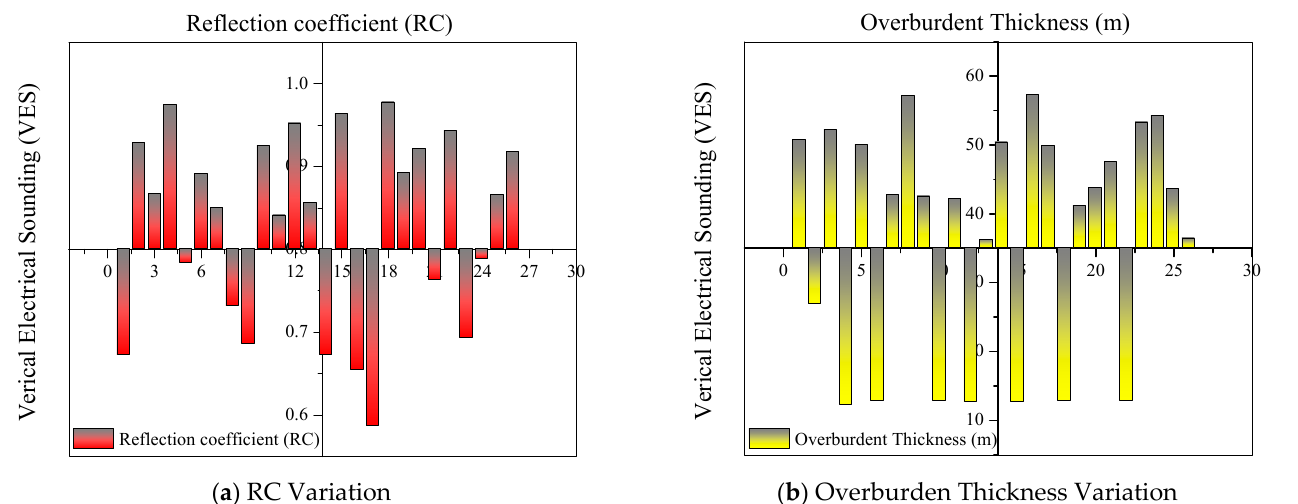
Figure 13. ( a ) Reflection coefficient ( RC); ( b ) overburden thickness along 26 VES stations in the surveyed area.